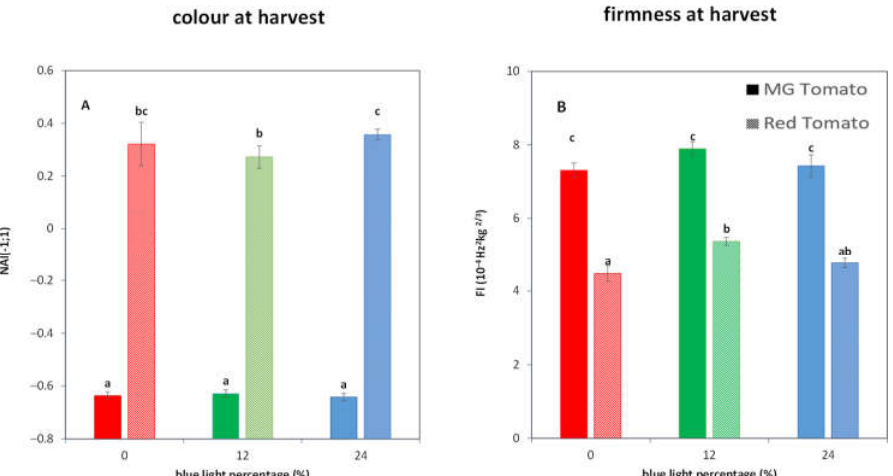
Figure 2. Average color at harvest ( A ), expressed as normalized anthocyanin index (NAI) and ( B ) firmness, expressed as FI index, at harvest of twenty-five MG (solid bars) and R tomatoes (dashed bars) with indicated standard error, respectively. Colors indicate tomatoes cultivated with 0 (red bars), 12 (green bars) and 24% (blue bars) additional blue light. The different letters in each panel indicate significant differences between light treatment.